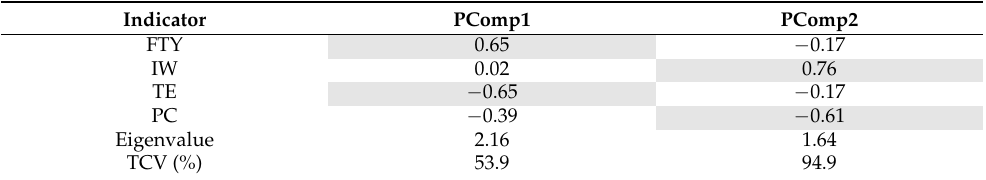
Table 3. Loading of the first two principal components (PComp) obtained for agronomic (FTY and IW), environmental (total carbon emissions, TE) and economic (PC) indicators. In gray: scores > |0.7|. TCV = total cumulative